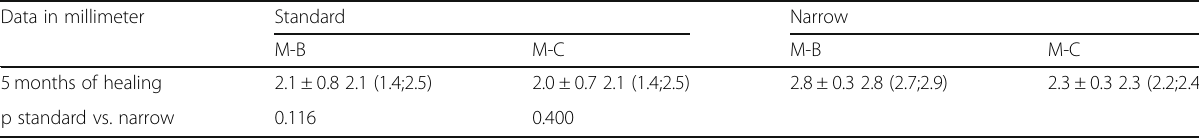
Table 2 Histological evaluation in millimeters at buccal-lingual aspects after 5 months of healing. Mean values ± standard deviation and median (25%;75% percentiles) of the two regular implants (3.8 mm and 4.25 mm) and of the two respective narrow